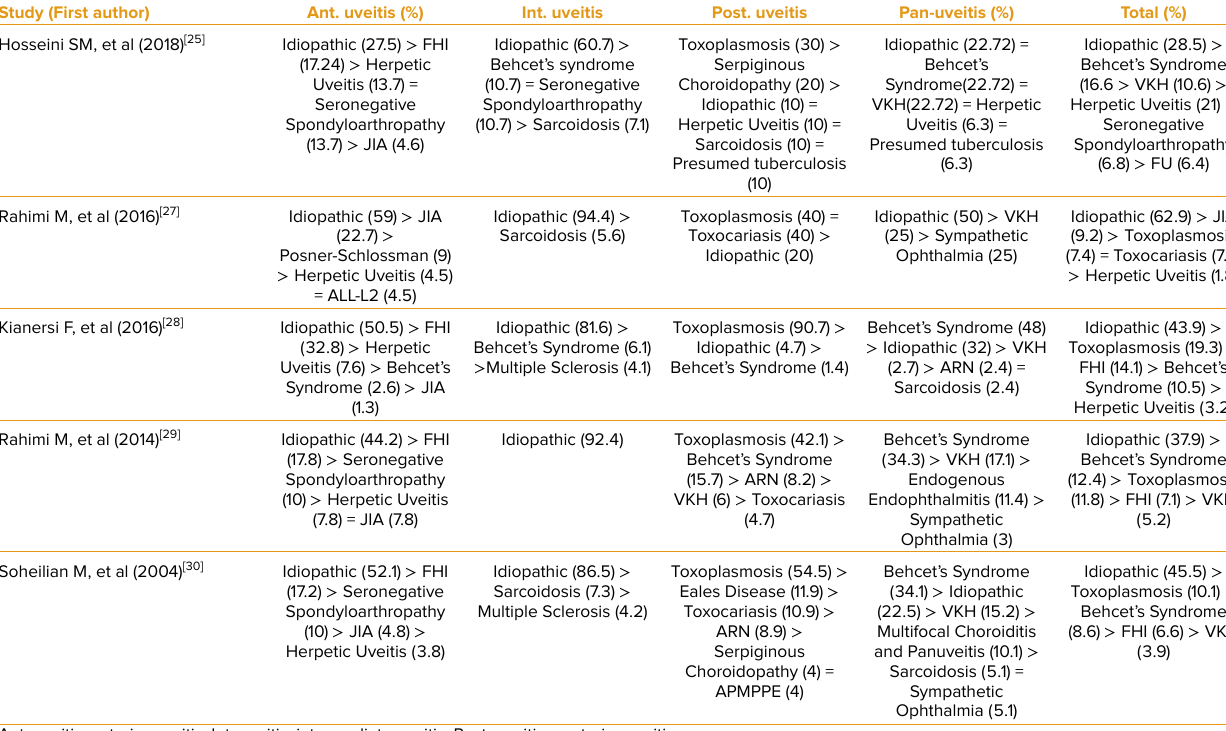
Table 3. Common etiologies of uveitis in different types in studies carried out at tertiary ophthalmology referral centers in Iran Study (First author)